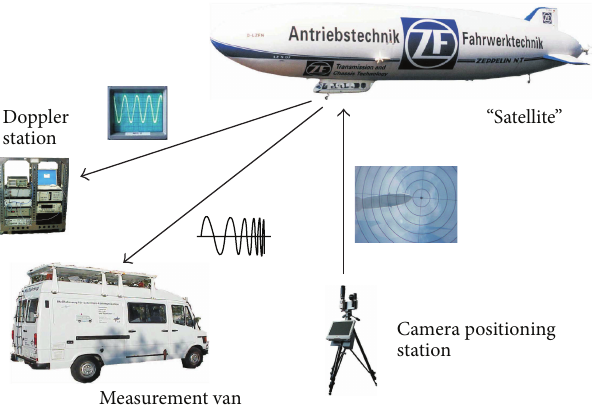
Figure 1: Measurement